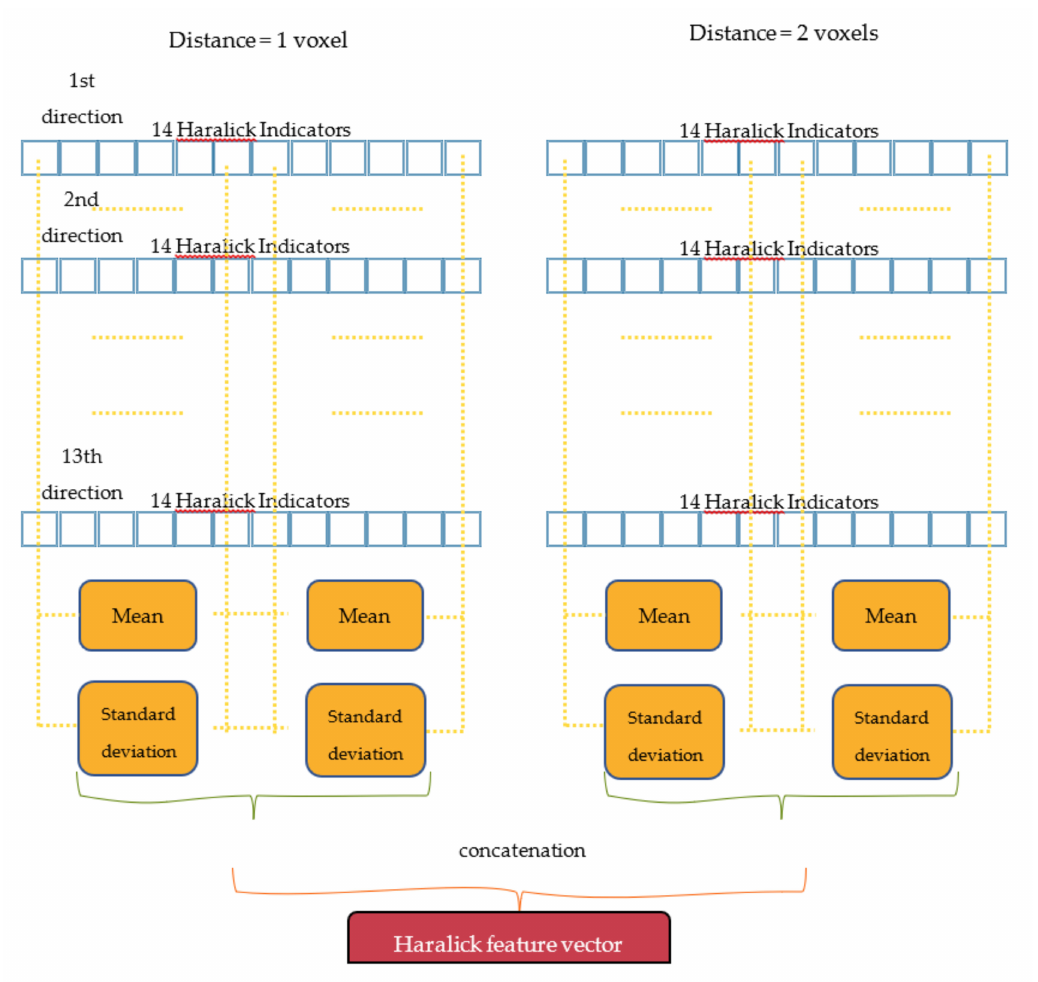
Figure 7. Feature vector computation from Haralick